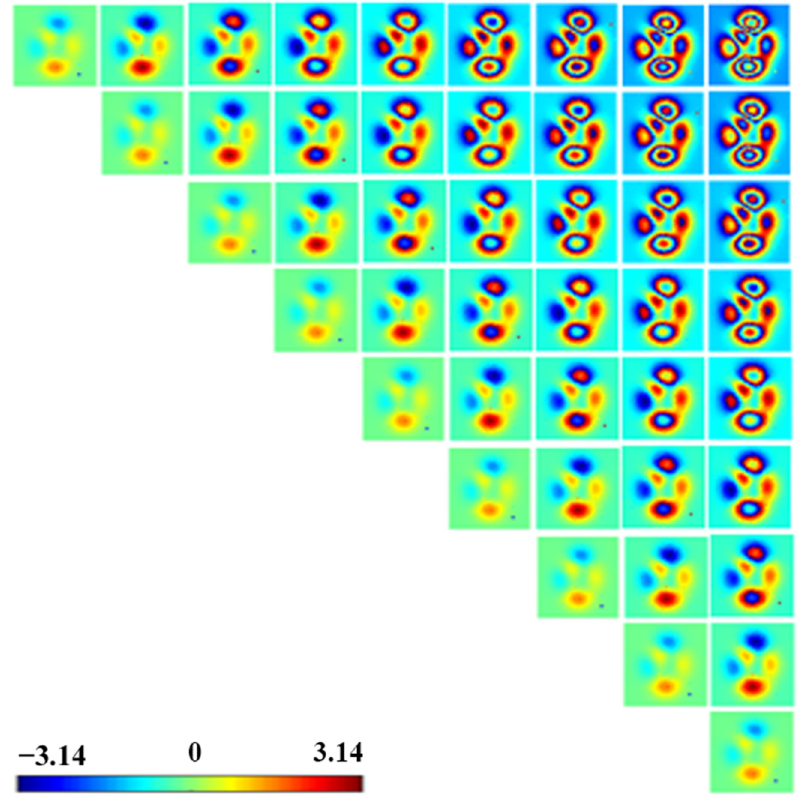
Figure 5. The simulated multi-temporal wrapped deformation